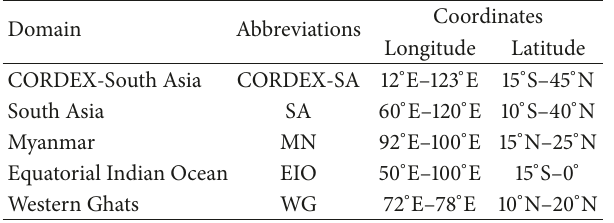
Table 1: Description of major domain (CORDEX-SA) and subdo- mains